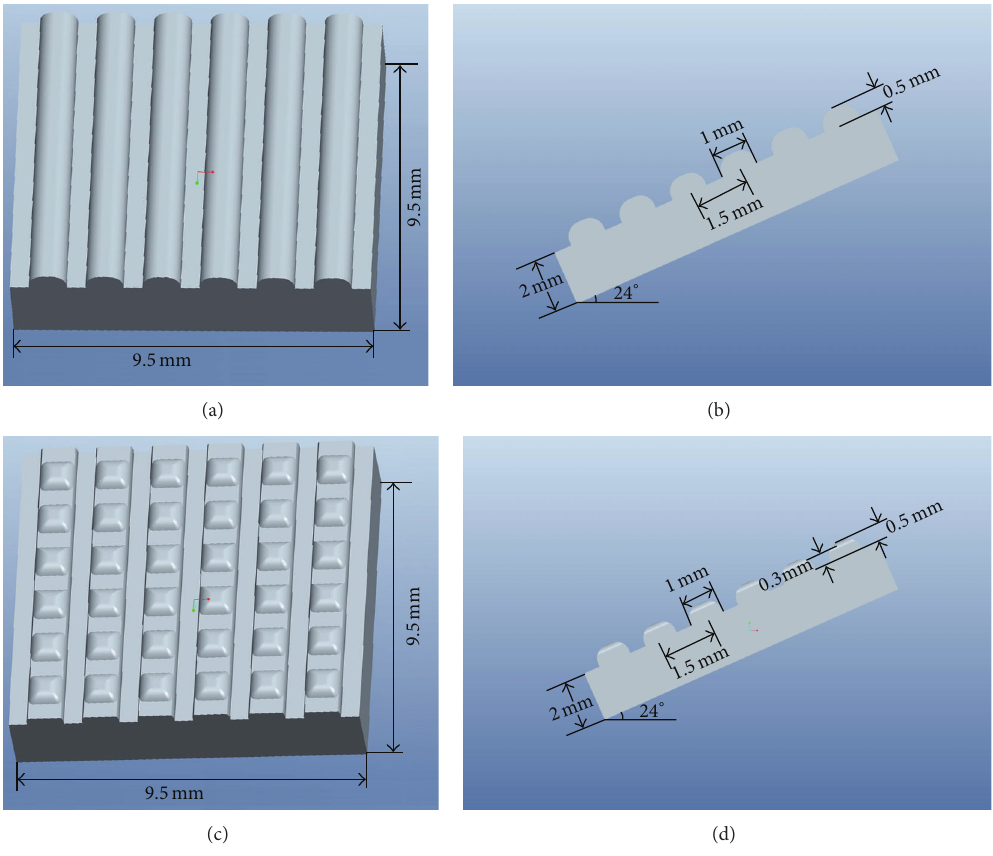
Figure 3: RMM and CSM and their parameters: (a) RMM mimics the right shell; (b) parameters of RMM, front view; (c) CSM mimics the left shell; and (d) parameters of CSM, front view.